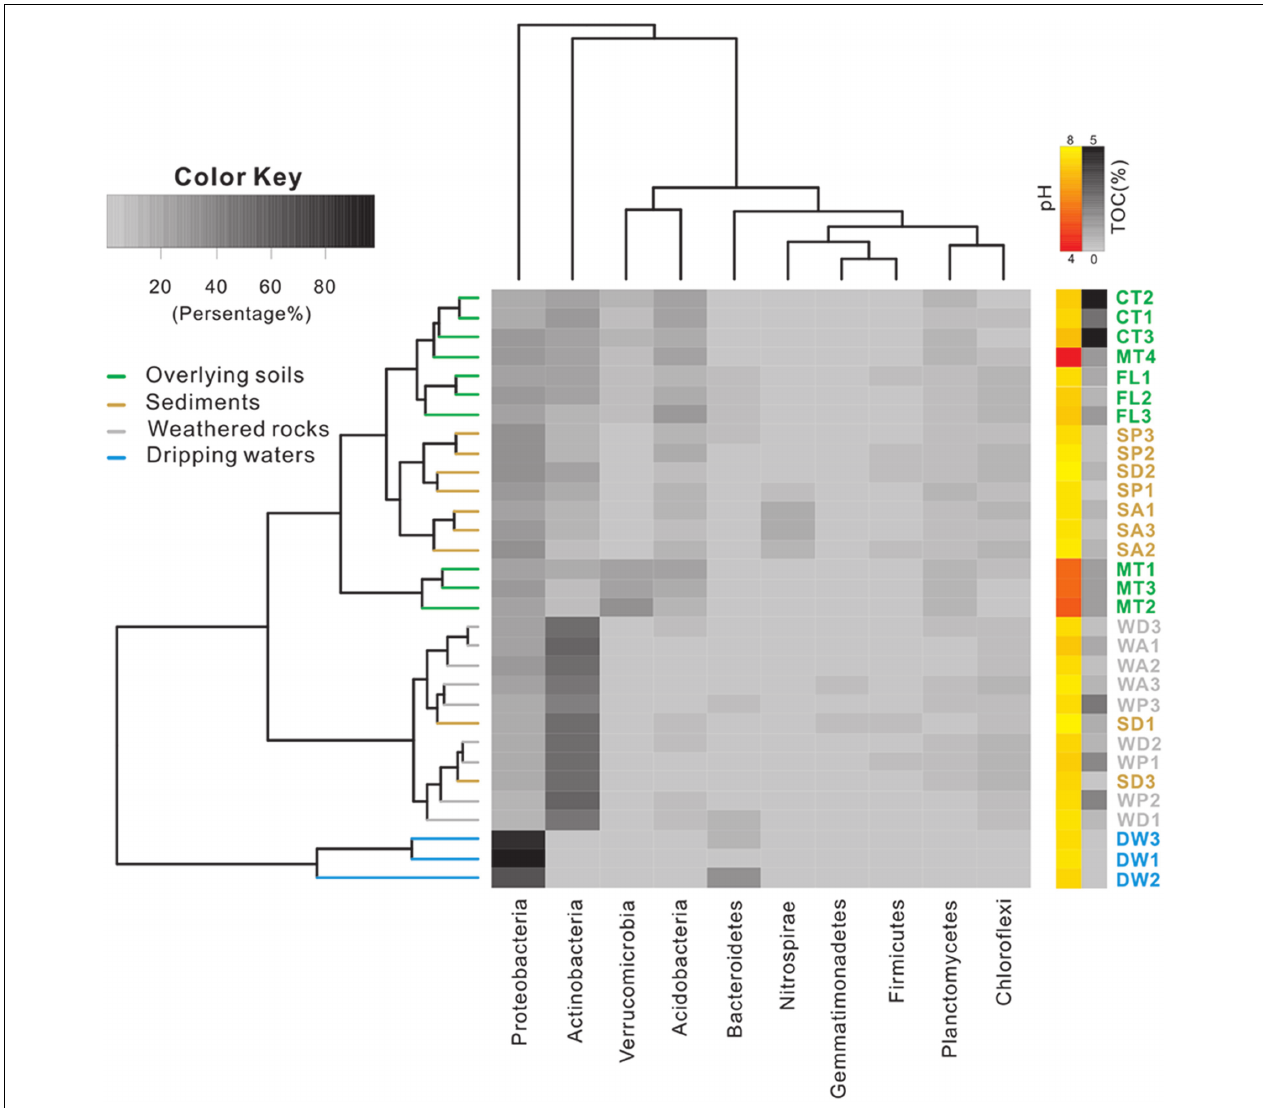
FIGURE 2 | Heatmap of 10 most abundant phyla in samples collected from Heshang Cave. Different colors denote samples of overlying soil (green), weathered rock (gray), sediment (brown), and drip water (blue). The pH and TOC for each sample are shown on the right, with pH, from acidic (red), neutral (orange), to alkaline (yellow) conditions, and TOC content from low (gray) to high (dark) values. Abbreviations are the same as listed for Figure 1